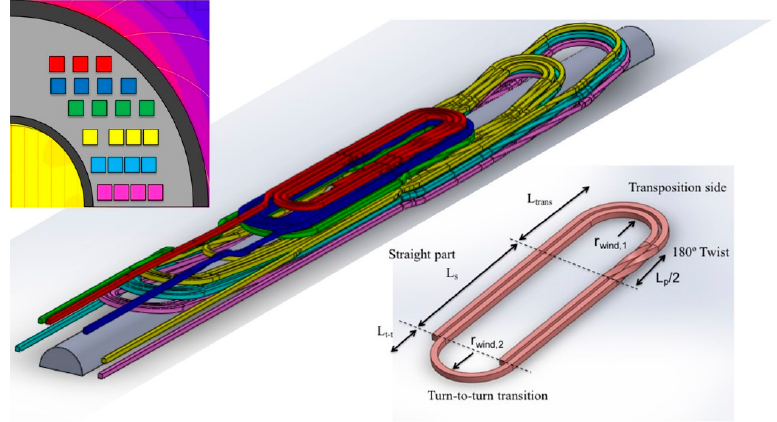
Figure 22. INP Grenoble dipole design with tape stack cable (4 mm tapes). Central: dipole coil layout (a racetrack with flared ends). Top left corner: one quarter dipole cross-section, each square is a tape stack—i.e., a 4 mm × 4 mm cable. Bottom left corner: cable twist of 180° in the winding to generate a tape transposition (courtesy of P. Tixador, INPG).